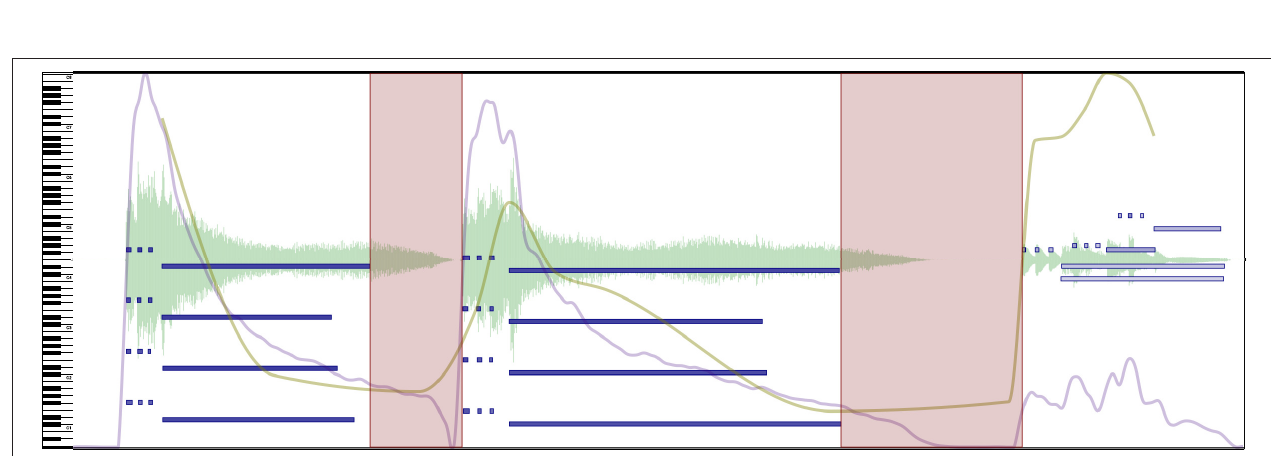
FIGURE 6 | Two pauses marked with regions (light red rectangles) in an excerpt of Beethoven’s Symphony No. 5 in C minor, Mvt I. Silence and timing are used to make the music breathe. See Supplementary Video 4 in the Supplementary Materials to hear the music presented in this Figure.